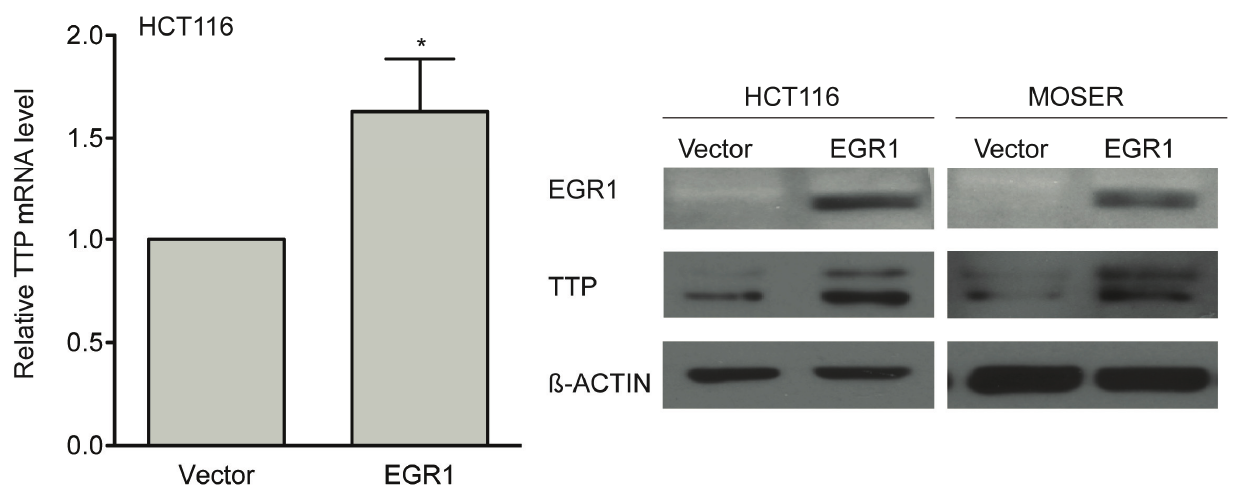
Figure 9. EGR1 expression induces TTP expression. HCT116 and Moser cells were transfected with 1 (cid:3)g of pcDNA3.1/Zeo/EGR1-Flag or vector control. Twenty-four hours post-transfection, cells were harvested for RNA and protein analysis. EGR1